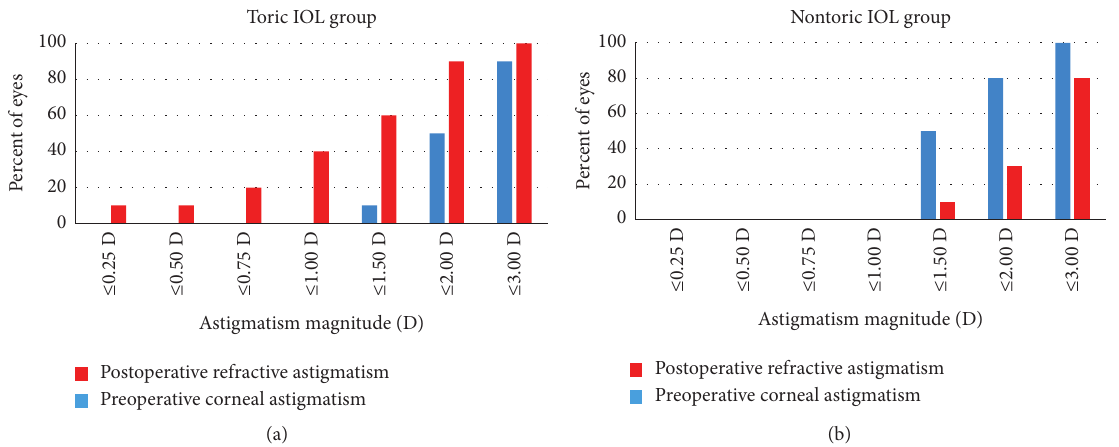
Figure 3: The magnitude of the preoperative corneal astigmatism and postoperative refractive astigmatism in the toric IOL and nontoric IOL